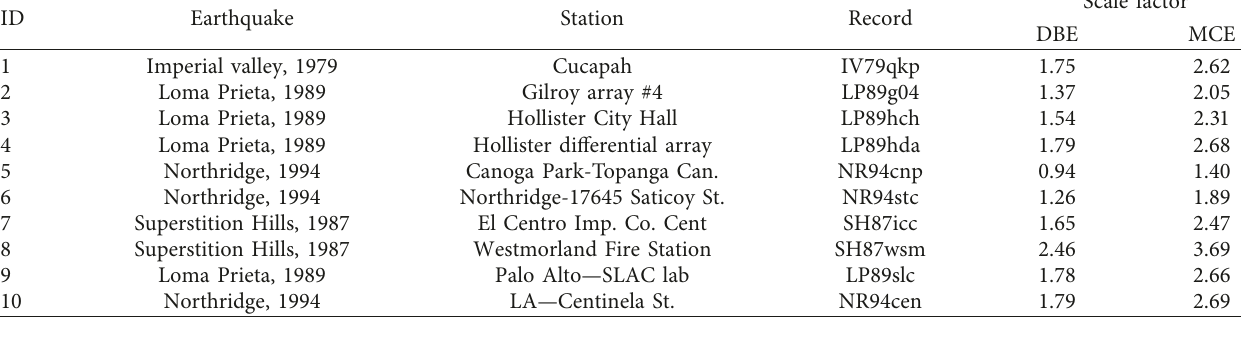
Table 2: Characteristics of the selected earthquake records.